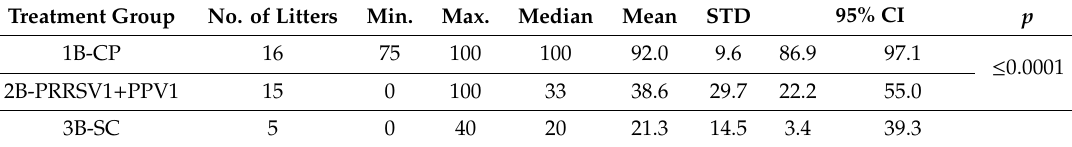
Table 3. Proportion (%) of piglets with at least one clinical finding from farrowing to day 20 of life in Experiment B. Di ff erences between treatment groups were tested by the Wilcoxon Mann–Whitney test. Min. = minimum value, Max. = maximum value, STD = standard deviation, CI = confidence interval. Treatment Group No. of Litters Min. Max. Median Mean STD 95% CI 1B-CP 2B-PRRSV1 + PPV1